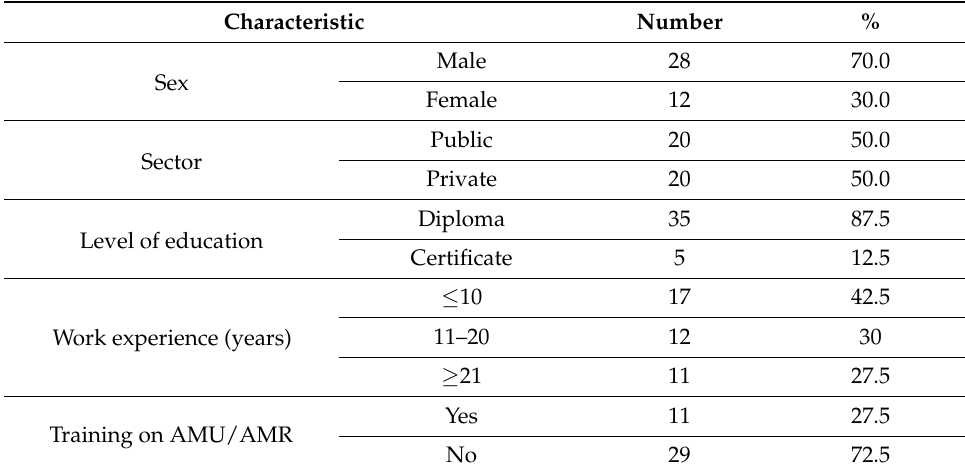
Table 1. Key characteristics of study